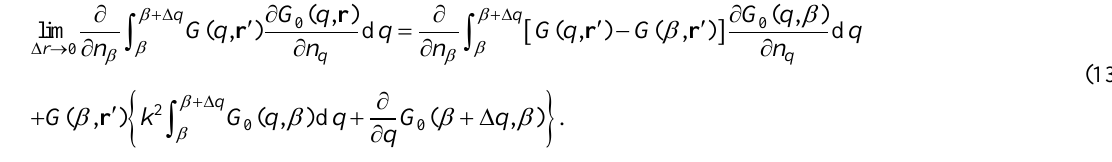
Fig. 3. Real part of the hypersingular integrand  ; solid red line: 0   r ; dashed, green line: 0.002   r